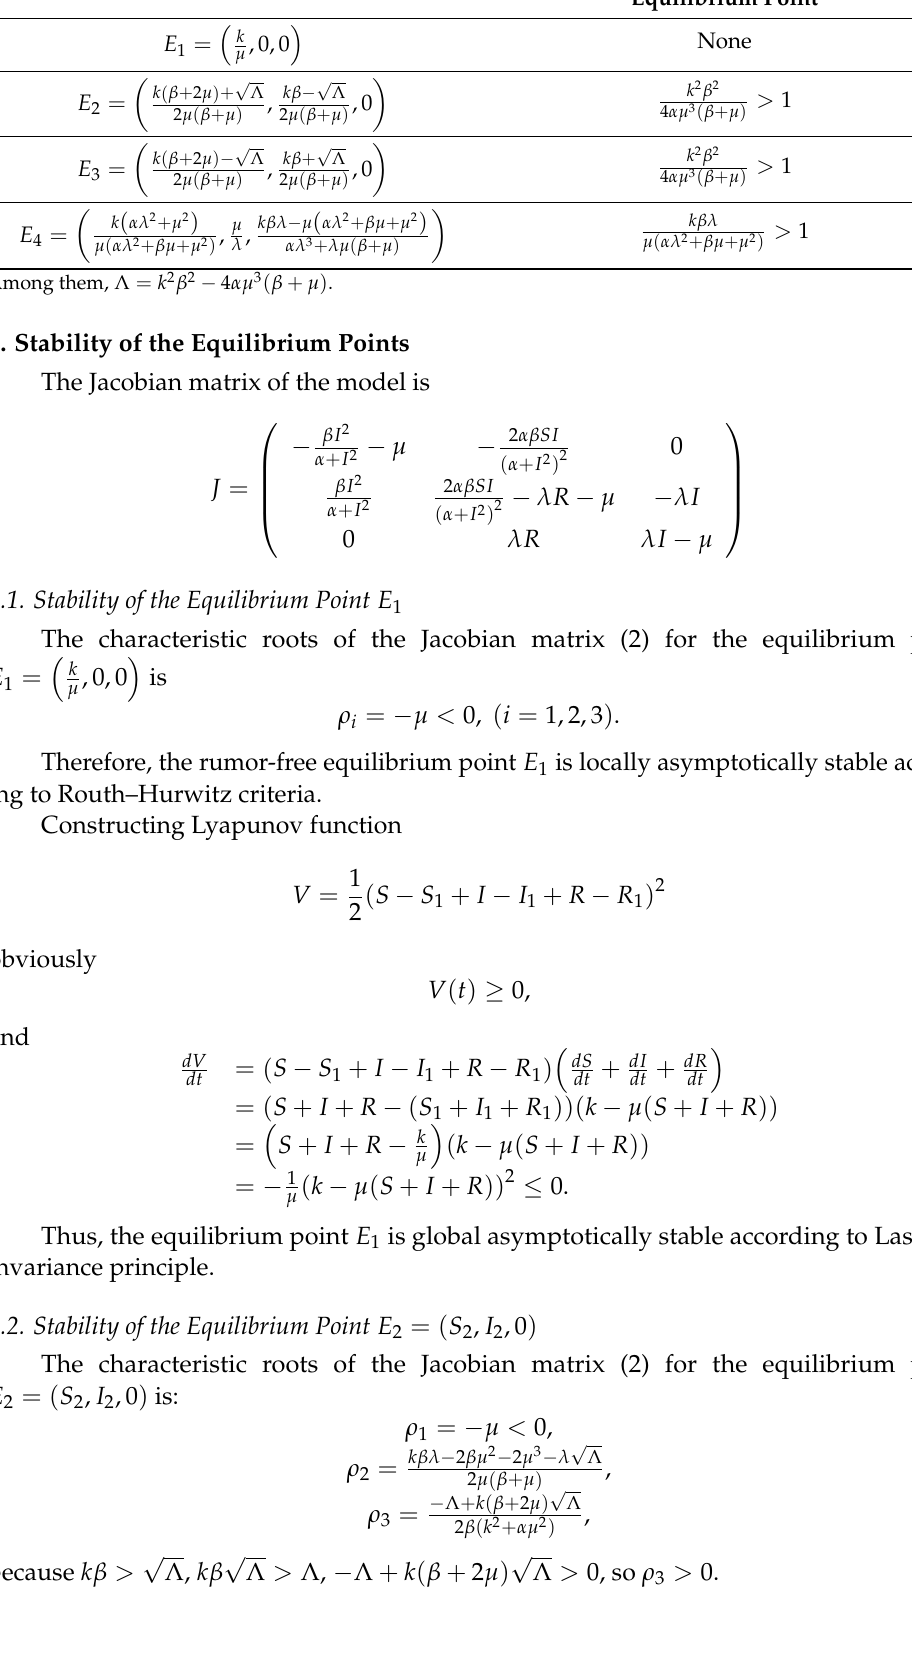
The Condition for Existence of the Equilibrium Point